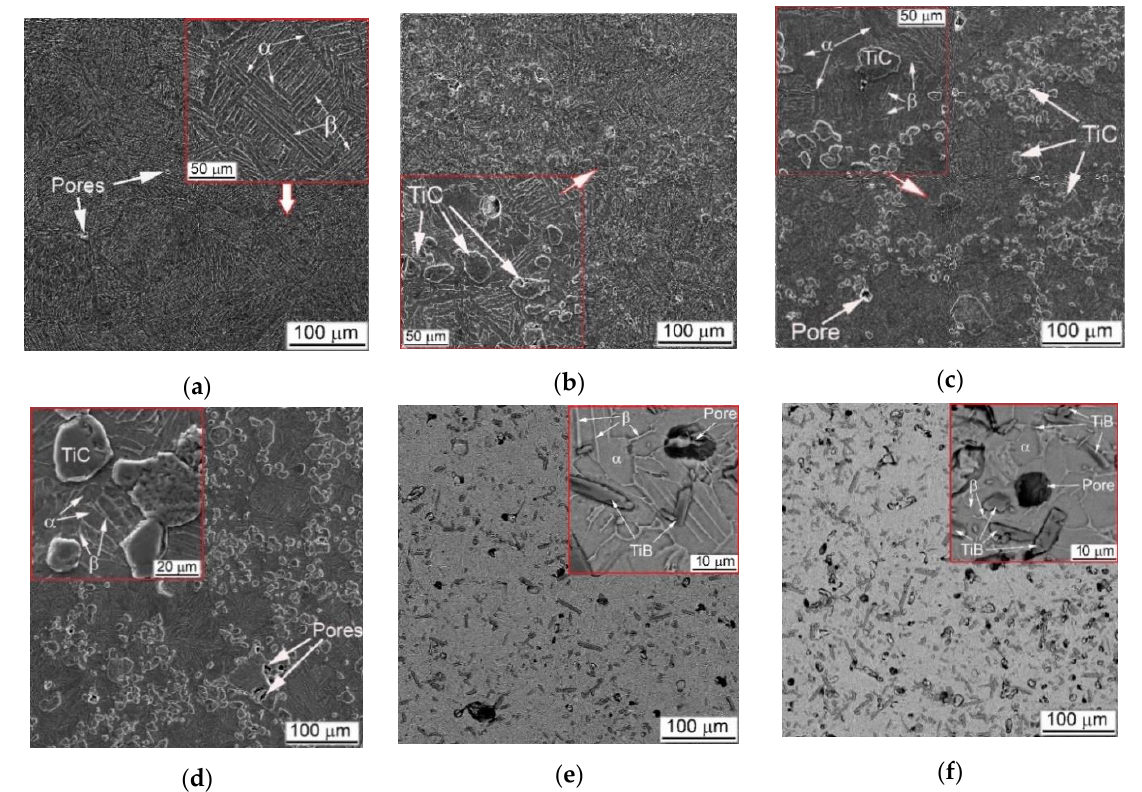
Figure 2. Microstructure of studied materials: ( a ) Ti64BEPM, ( b – f ) MMC on the base of Ti64BEPM containing ( b ) 5 (vol.) % TiC, ( c ) 10% TiC, ( d ) 20% TiC, ( e ) 5% TiB, and ( f ) 10% TiB particles. SEM, ( a – d ) BSE, ( e , f) SE images. Table 1. Chemical and phase composition of studied materials. Alloying Elements and Impurities, ##